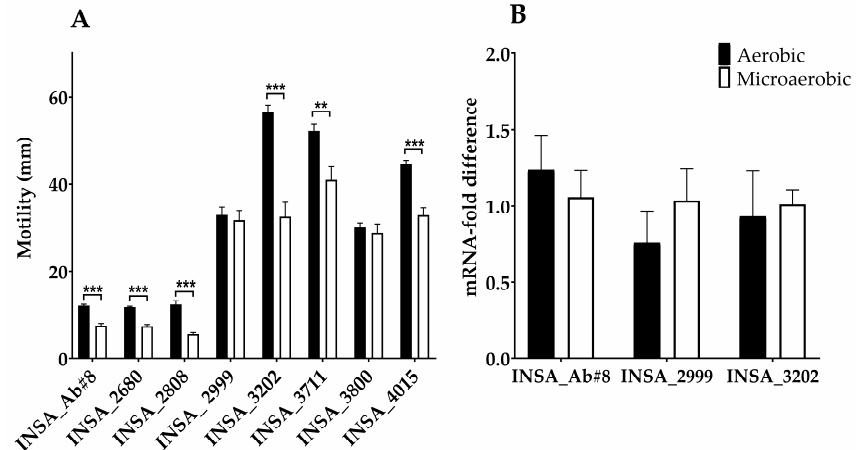
Figure 5. ( A ) Motility halo of eight clinical isolates of Arcobacter butzleri in millimetres when growth in aerobic or microaerobic conditions. ( B ) Comparison of the relative expression of the flaA by qPCR in Arcobacter butzleri INSA_Ab#8, INSA_2999 and INSA_3202 isolates when comparing aerobic versus microaerobic conditions. Results were analysed using Student’s t -test. The data shown represent the mean ± standard deviation of at least three independent assays. ** p < 0.01, *** p <